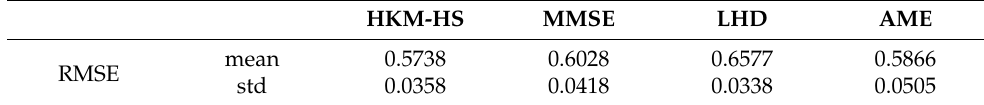
Table 8. Comparison of modeling results of house heating.